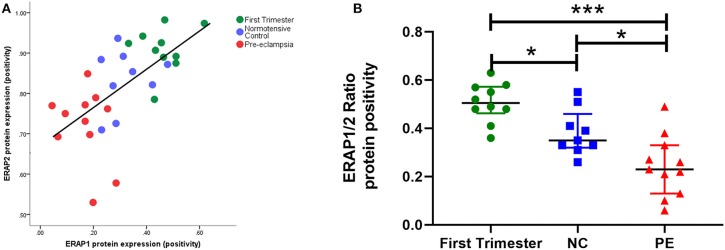
(A) Scatter plot illustration shows a strong positive correlation between endoplasmic reticulum aminopeptidase (ERAP)1 and ERAP2 placental protein expression (r = 0.70; P < 0.0001); (B) box plots of ERAP1/ERAP2 ratios in first trimester tissue (n = 12), normotensive control (NC; n = 12), and pre-eclampsia (PE; n = 12). Data are presented as median [interquartile range (IQR)]; *P < 0.05; ***P < 0.0001.